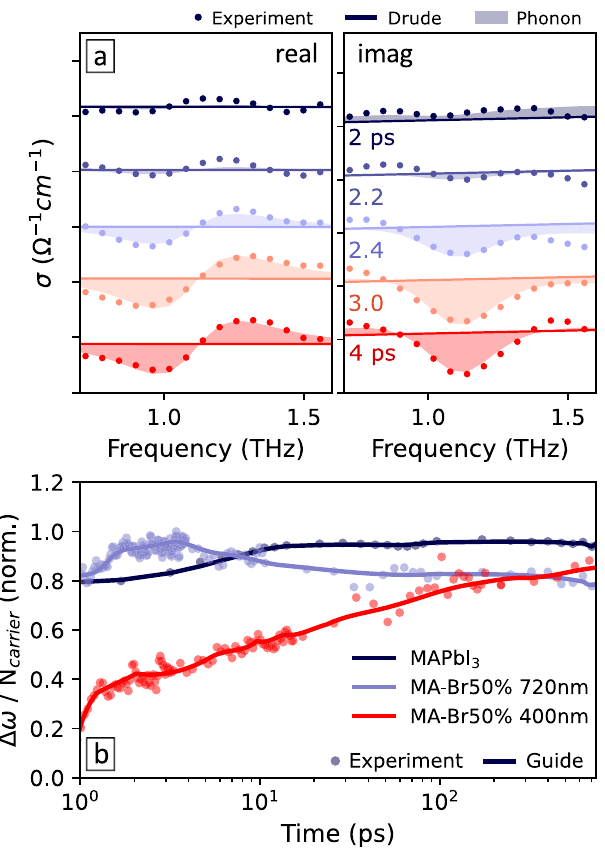
Fig. 3 Picosecond evolution of phonon anharmonicity features in OPTP photoconductivity following pulsed photoexcitation. a THz photoconductivity spectra at various time delays following 400nm photoexcitation of the MAPb(I 0.5 Br 0.5 ) 3 thin fi lm after phase segregation. The spectra were offset for clarity. b Photoexcitation-induced phonon frequency shift Δ ω divided by carrier density N (and subsequently normalised for comparison), extracted from fi ts to the photoconductivity spectra as a function of time delay following photoexcitation. Dots show the fi tted values extracted from data of a MAPbI fi lm with 400 nm 3 thin photoexcitation (dark blue), MAPb(I 0.5 Br 0.5 ) 3 thin fi lm with 400 nm (red), and 720 nm pump (light blue), respectively. Solid lines are splines to guide the